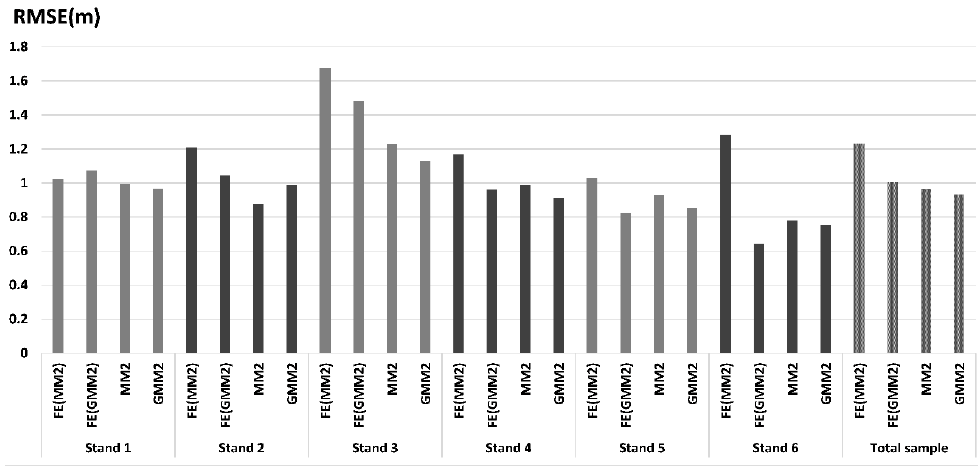
Figure 7. Root mean square error values per sample plot and total sample during model evaluation against independent data of crown width-diameter. FE = fixed-effect part of the corresponding model in the parenthesis.